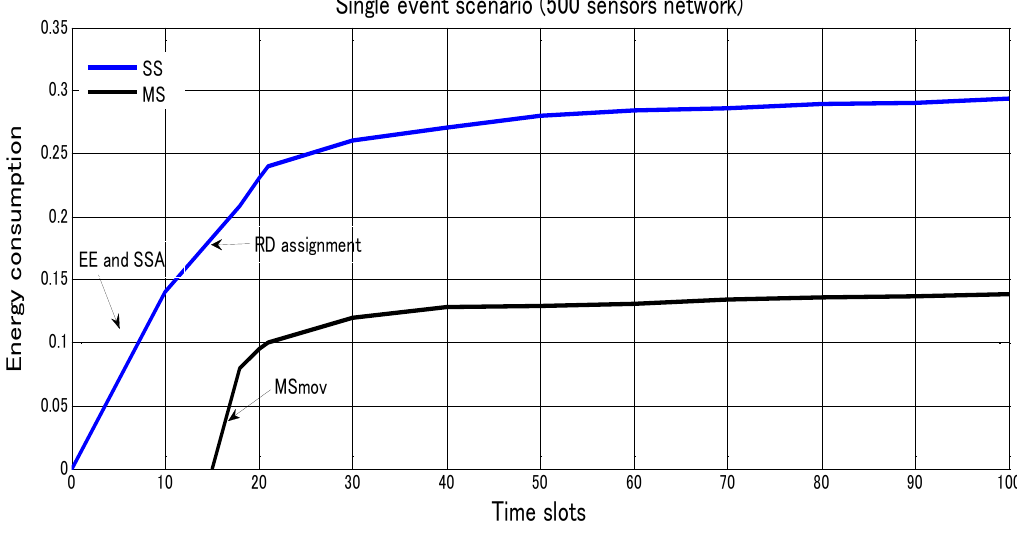
Figure 12. Energy consumption of SS and MS based on the spent time slots under a single-event scenario with 500 sensors randomly distributed over a 100*100 network area.